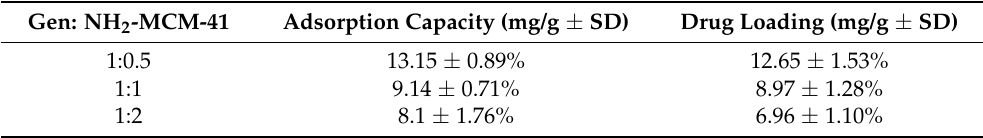
Table 2. The adsorption capacity and drug loading of Gen and NH 2 -MCM-41 in different proportions.